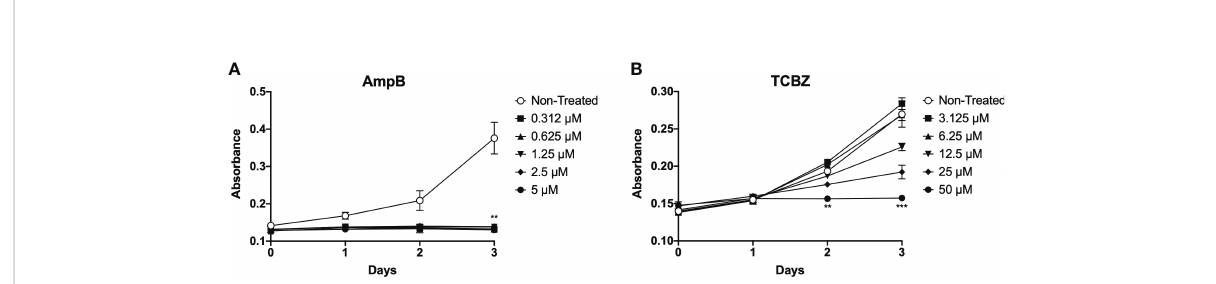
FIGURE 2 L. amazonensis promastigotes proliferation analysis. (A) Parasites treated with increasing concentrations of AmpB (0.312, 0.625, 1.25, 2.5 and 5 µM). For AmpB, statistically signi fi cant results were presented in all concentrations on the third day (72h) of treatment. (B) Parasites treated with increasing concentrations of TCBZ (3.12, 6.25, 12.5, 25 and 50 µM). For TCBZ, statistically signi fi cant results obtained in 50 µM concentrations from day 2 (48h) of the analysis. Absorbance (Abs) read at 600 nm. .